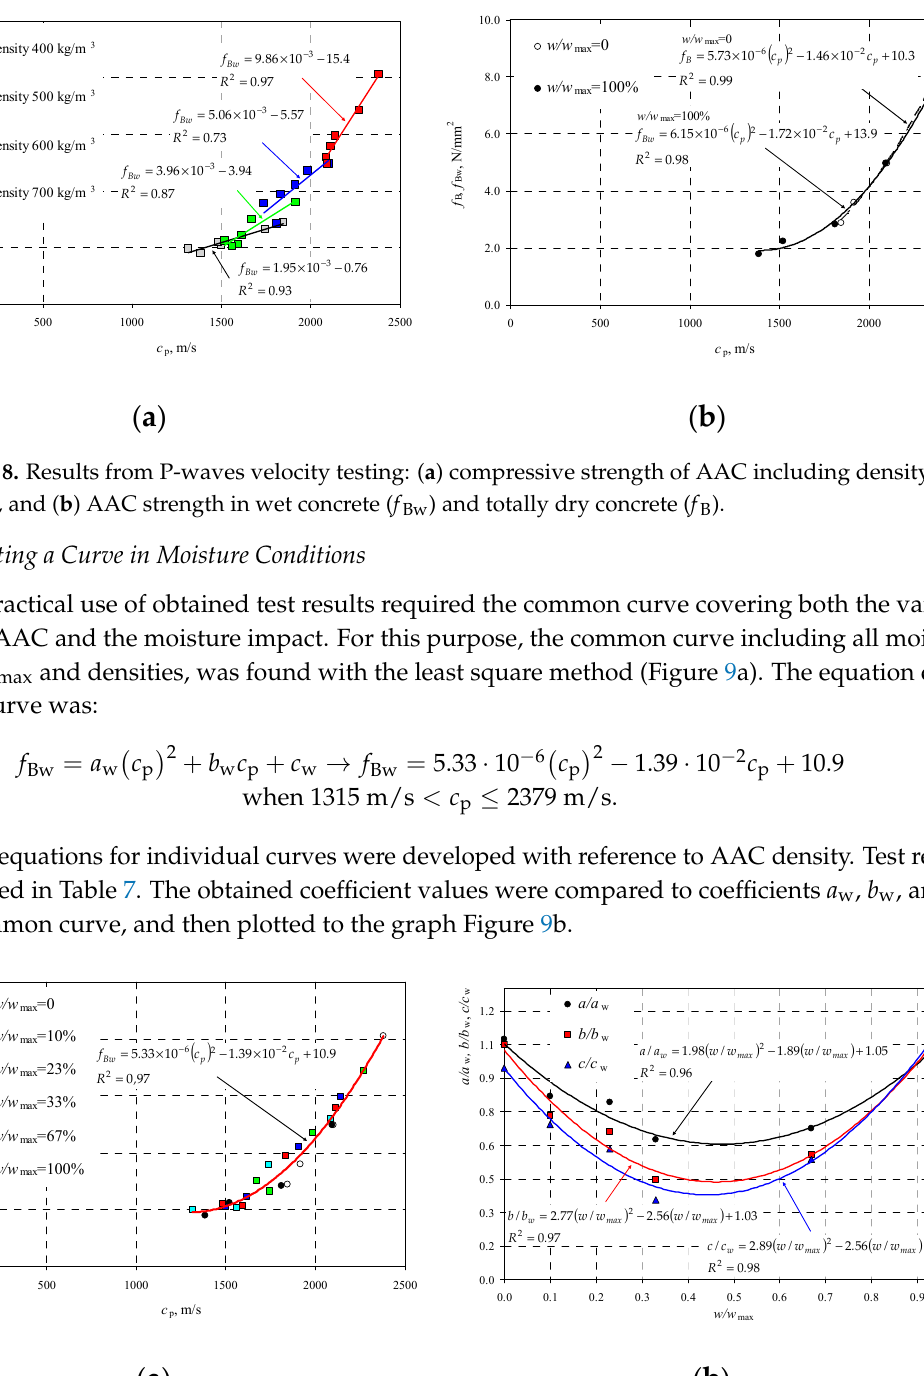
Figure 8. Results from P-waves velocity testing: ( a ) compressive strength of AAC including density classes, and ( b ) AAC strength in wet concrete ( f Bw ) and totally dry concrete ( f B ).